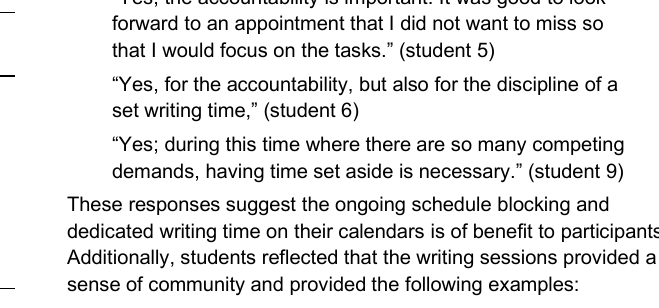
Table 1. Sample Structure of a Writing Session DATA SOURCES AND